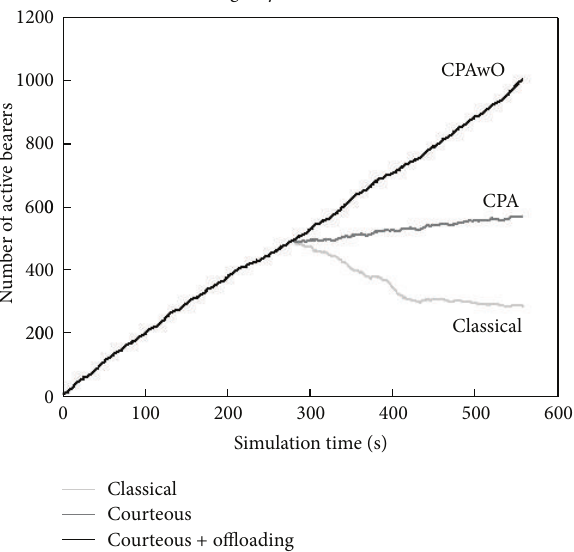
Figure 5: Number of PS nonemergency active bearers.